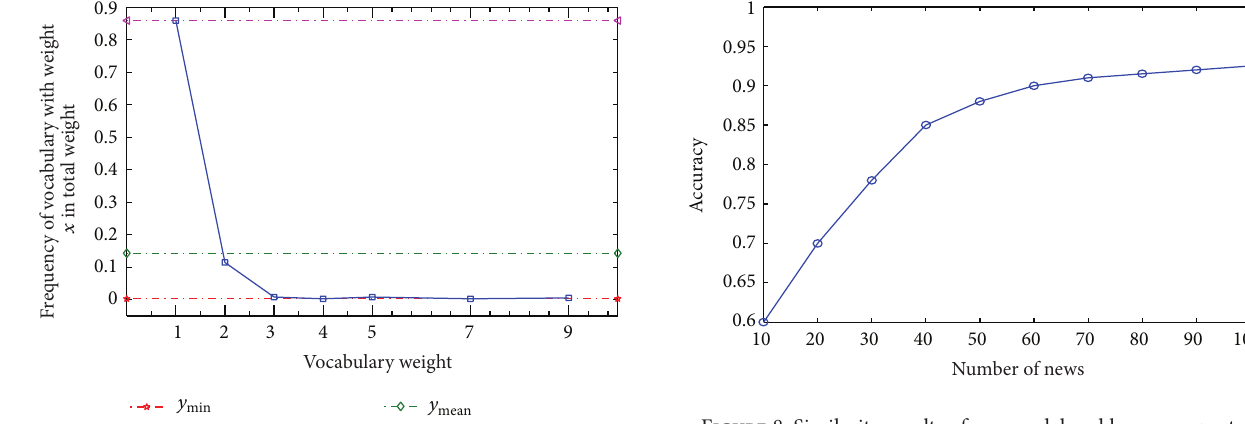
Figure 8: Similarity results of our model and human